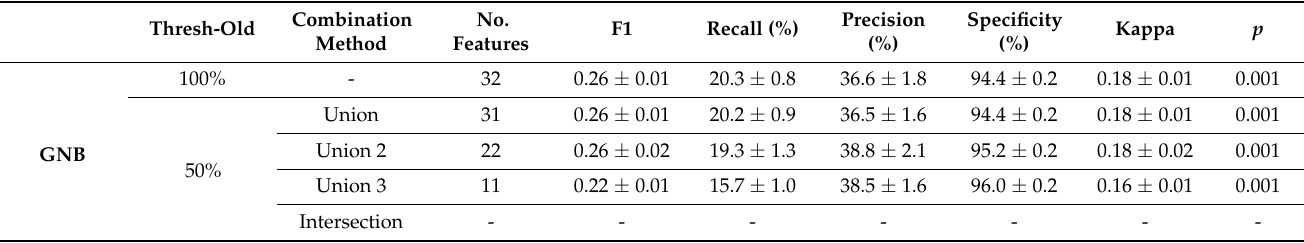
Table A9. Performance of the four classification models on detection fall using Mobility Lab Romberg stance with open eyes data set ; Gaussian Naive Bayes (GNB); Decision Tree (DT); k-Nearest Neighbor (kNN); Support Vector Machine (SVM); p -value via permutation